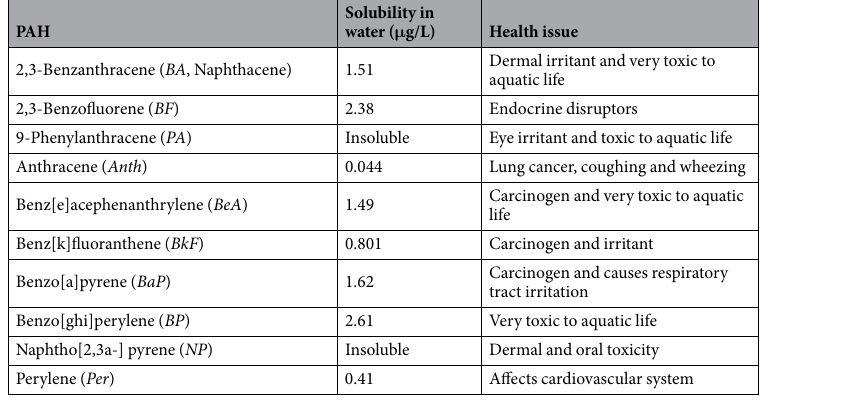
Table 1. The solubility of PAHs in water and their associated health issues 34–38